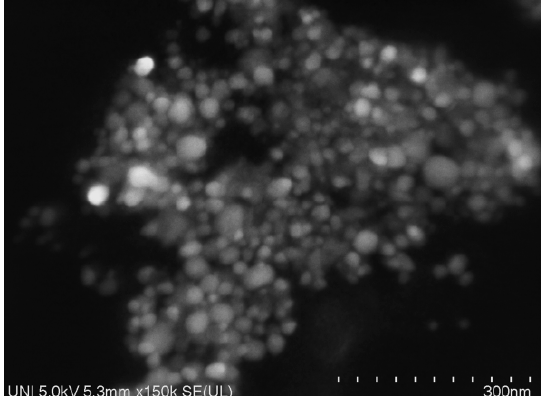
Figure 5. STEM photomicrograph of the synthesized AgNPs conjugated with the ethanolic fraction of Lepechinia meyenii (salvia).